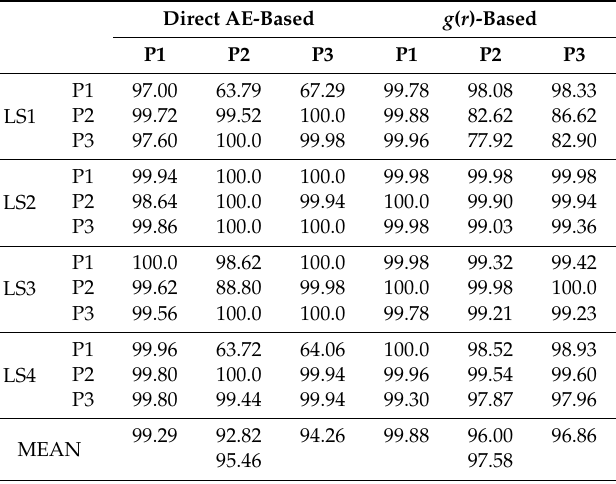
Table 10. Accuracy (%) of classifiers trained with leak L4. Direct AE-Based